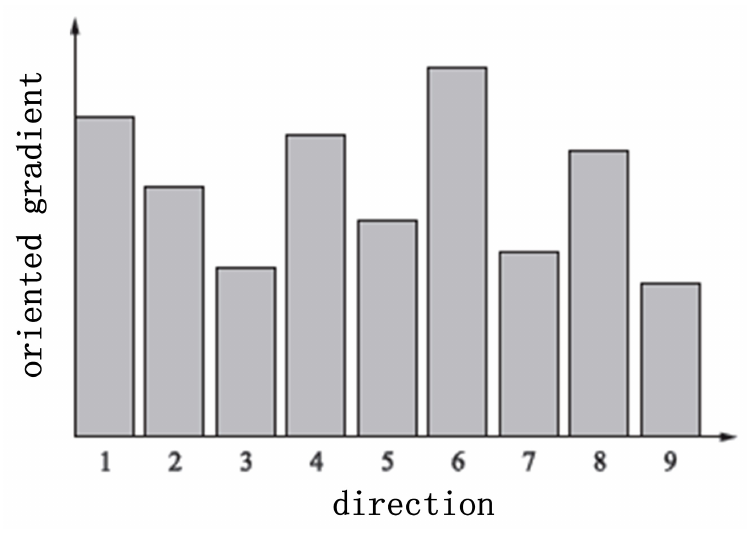
Figure 3. A typical histogram of oriented gradients for one cell.